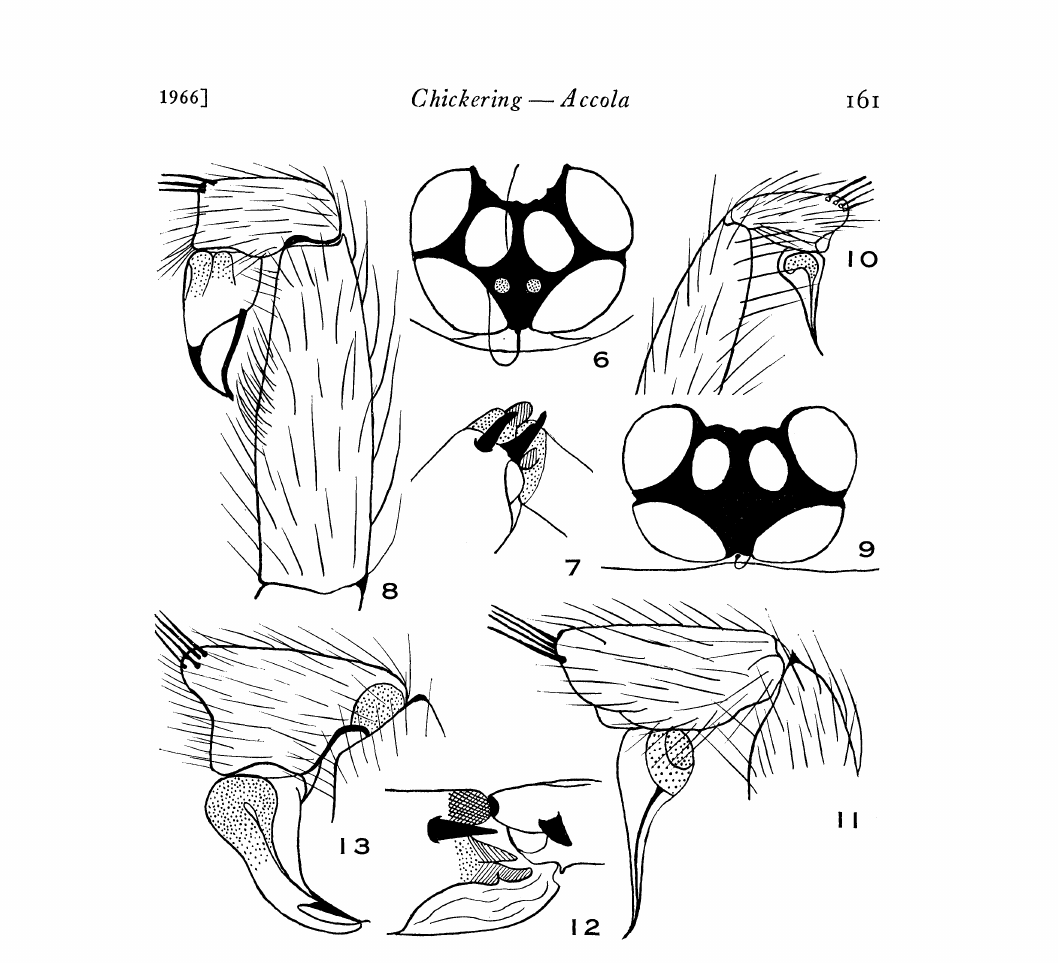
Figs. 6-8. lccola simla sp. nov. Fig. 6. Eyes of male holotype as seen :rom above. Fig. 7. Spines and associated parts at articulation of first left tibia and metatarsus of male holotype; prolateral view. Fig. 8. Left palpal tibia and tarsus of male holotype; retrolateral view. Figs. 9-11. lccola barona sp. nov. Fig. 9. Eyes of male holotype as seen from above. Figs. 10-11. Left palpal tibia and tarsus of male holotype; prolateral and retrolateral views, respectively. Figs. 12-13../lccola spinosa Pet. Fig. 12. Spines and associated parts at articulation of first left tibia and metatarsus of male; prolateral view. Fig. 13. Left palpal tibia and tarsus; retrolateral